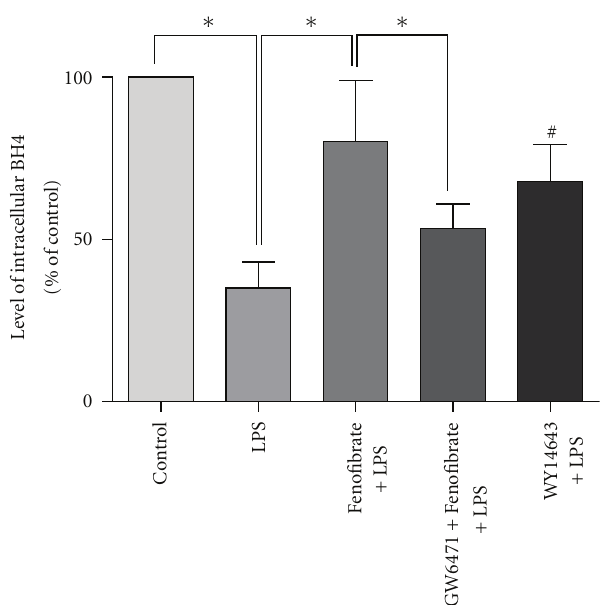
Figure 3: E ff ect of fenofibrate and related compounds on intra- cellular level of BH4 in each group, measured by HPLC. Values are expressed as means ± SD. BH4: tetrahydrobiopterin. n = 5. ∗ P < 0 . 05; # P < 0 . 05 versus LPS group.